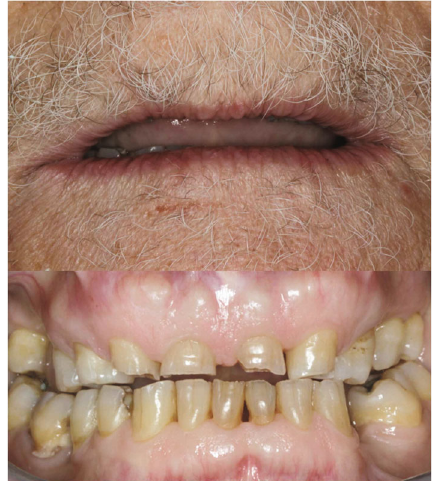
Figure 5: Extraoral and intraoral view of the severely worn dentition.